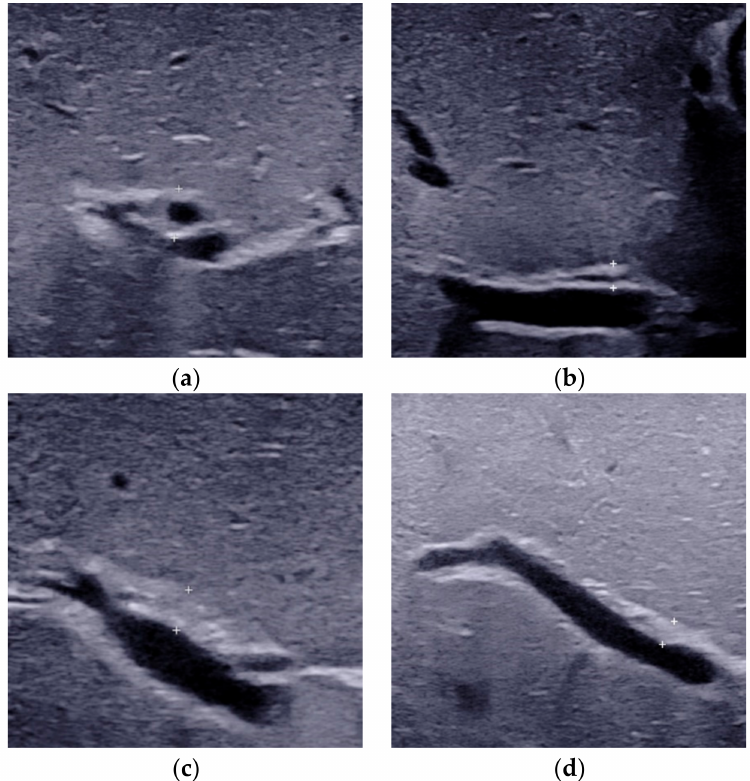
Figure 2. The triangular cord thickness measured above the anterior branch of the right portal vein on a longitudinal image. ( a ) The TC thickness >4.0mm including HA in BA. ( b ) The TC thickness <4.0 mm including HA in non-BA. ( c ) The TC thickness >2.0 mm not including HA in BA. ( d ) The TC thickness <2.0 mm not including HA in non-BA. TC, triangular cord; HA, hepatic artery; BA, biliary